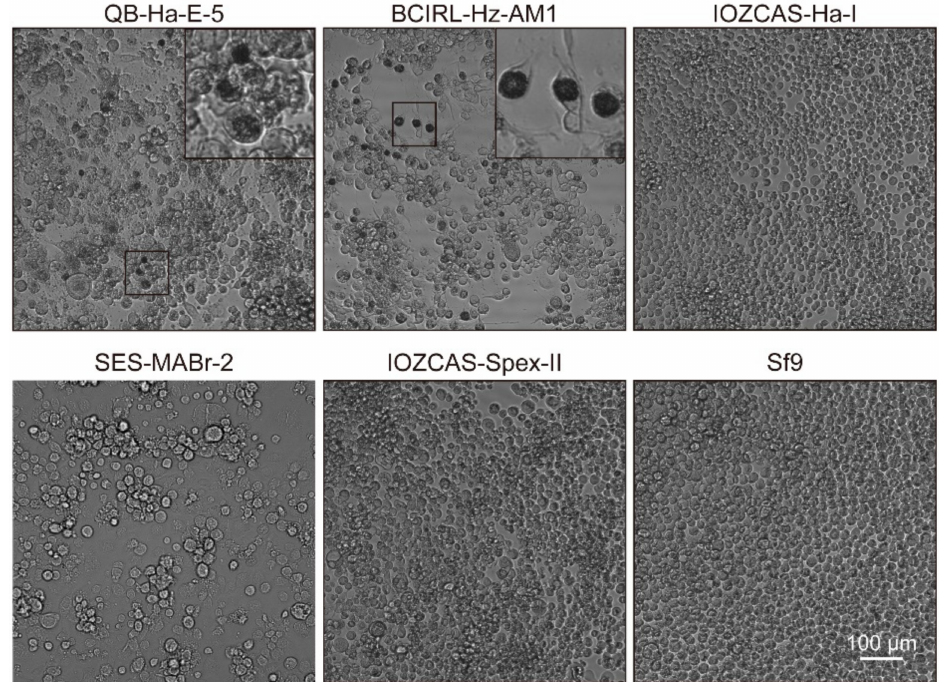
Figure 2. The images of 6 different insect cell lines infected with HearNPV-BJ. The polyhedron can be seen in the small frame of QB-Ha-E-5, BCIR1-Hz-AM-1, but not in IOZCAS-Ha-I, SES-MABr-2, IOZCAS-Spex-II and